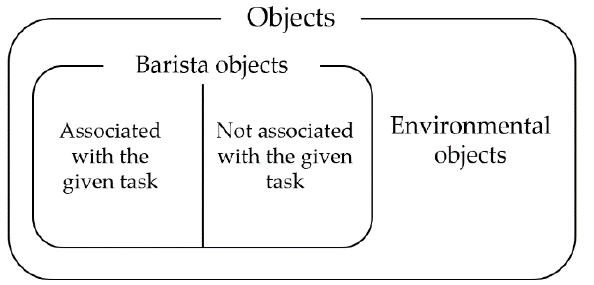
Figure 5. Relationship among objects appearing in VR-based barista training contents.